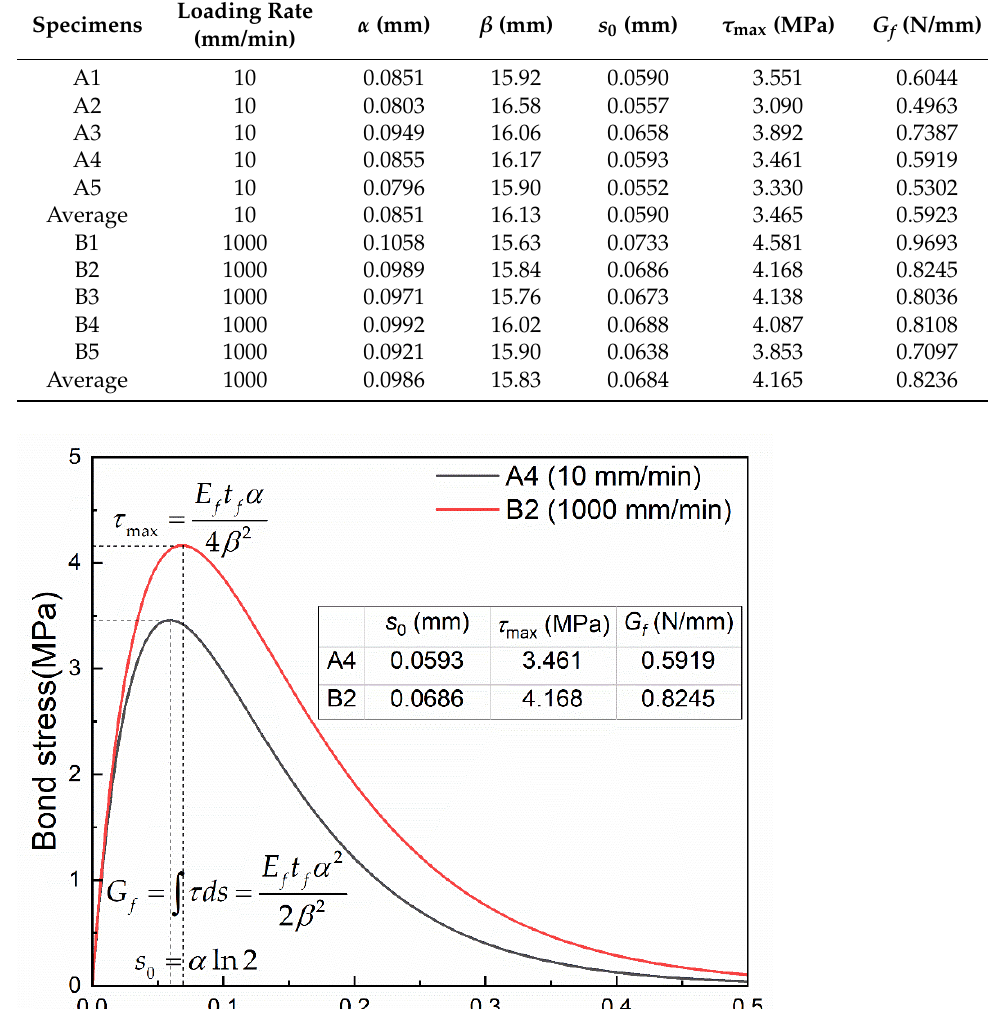
Table 2. The bond–slip parameters from the tests.